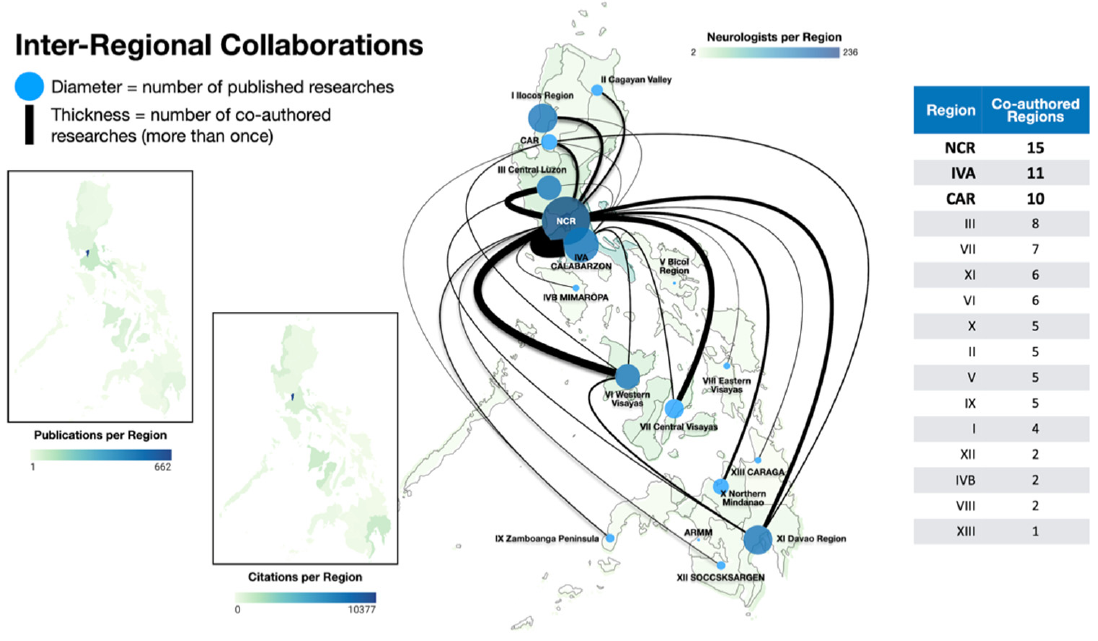
Figure 2. Philippine national map with inter-regional collaboration networks and choropleth of bibliometric indices and number of neurologists composited.